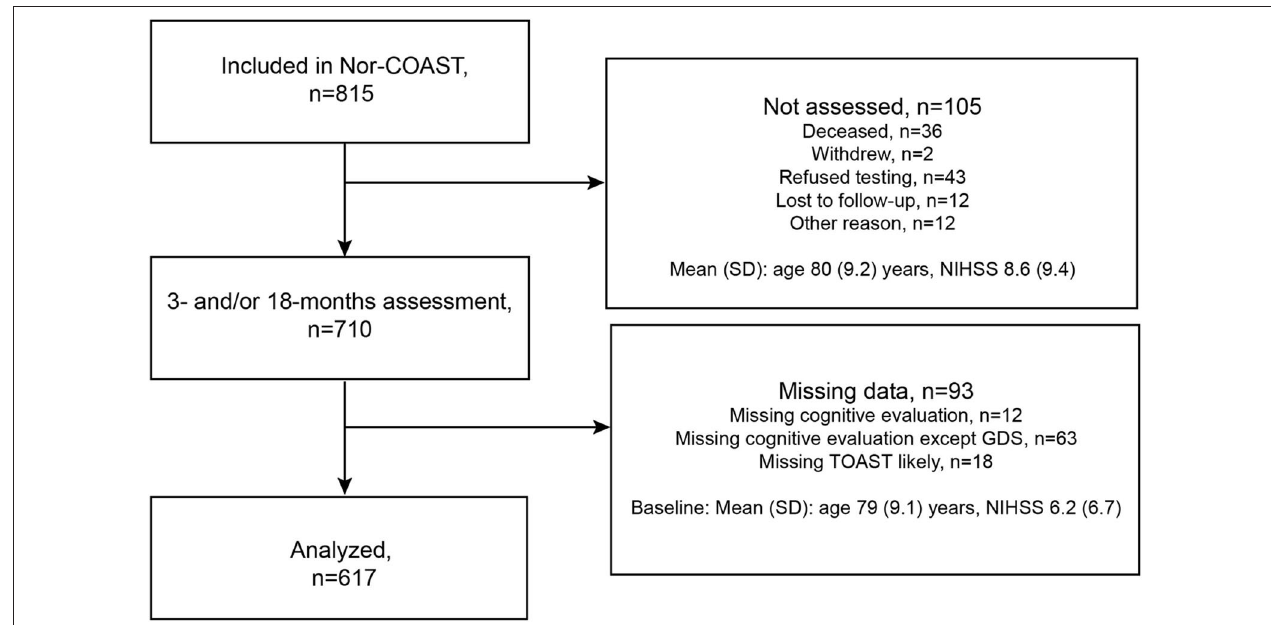
FIGURE 1 | Flowchart of participants included in the